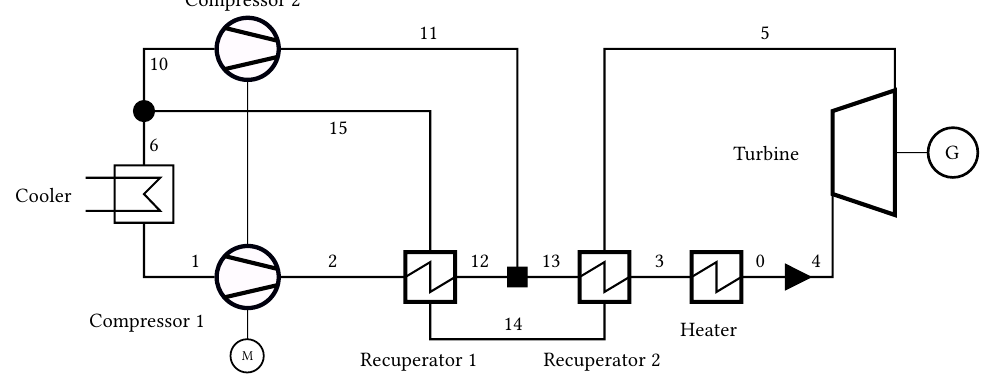
Figure 7. Flow chart of sCO 2 power cycle implemented in